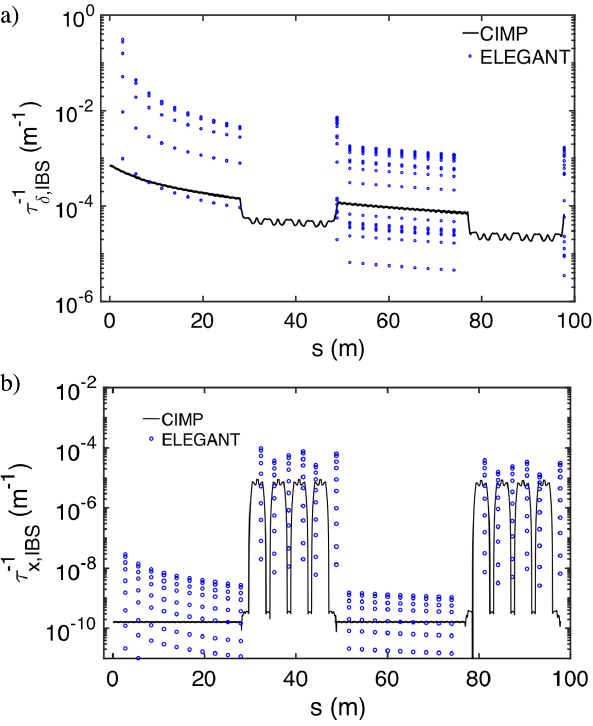
5. The calculated IBS growth rates along the recirculating beamline for (a) slice energy spread, and (b) the transverse horizontal emittance. The solid lines are from CIMP model and the blue dots are from ELEGANT through IBSCATTER element [83]. There is a total of 30 blue dots at a certain location s, corresponding to the number of IBS bins [see Table